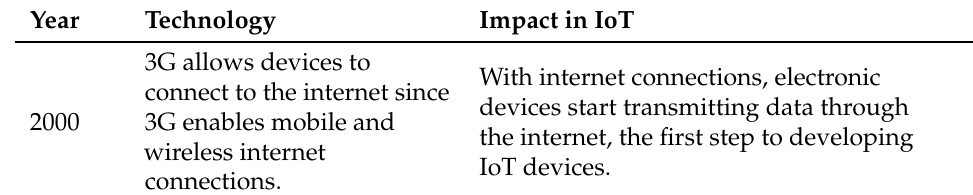
Table 5. Mobile generations and IoT.